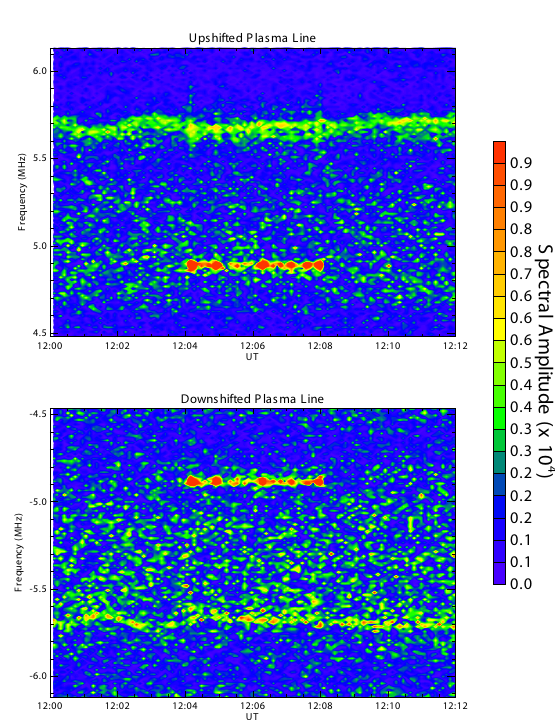
ESR PLASMA LINE Plasma Line Spectral Amplitude for 27/04/2004